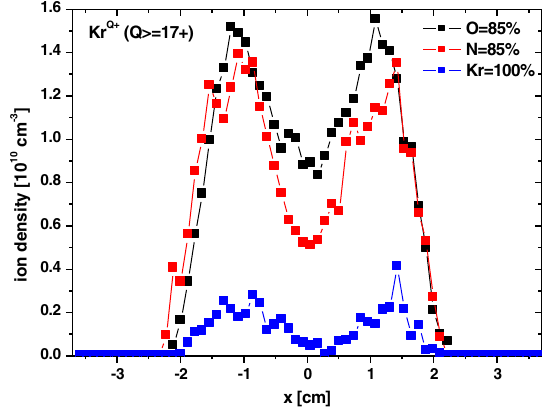
FIG. 12. Density of the krypton ions with the charge states greater and equal to ( 17 þ ) along the x axis in the middle of the source ( z ¼ 14 cm) for the mix with oxygen (O ¼ 85 %, black) and nitrogen (N ¼ 85 %, red) and with no mix (Kr ¼ 100 %,